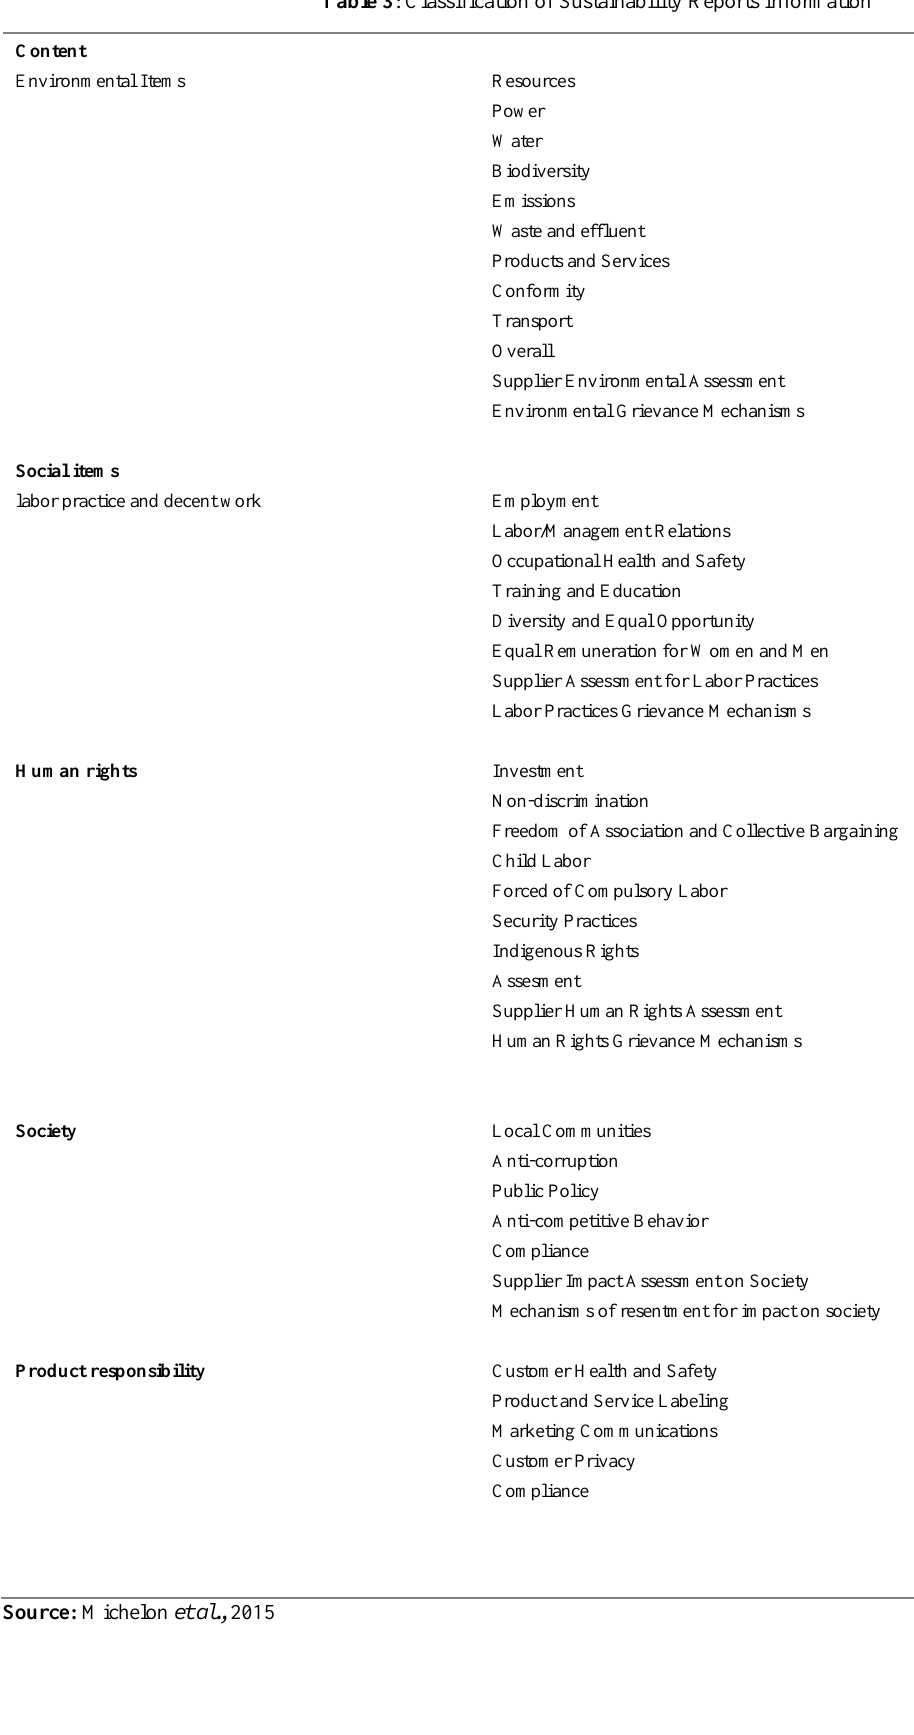
Table 3 : Classification of Sustainability Reports